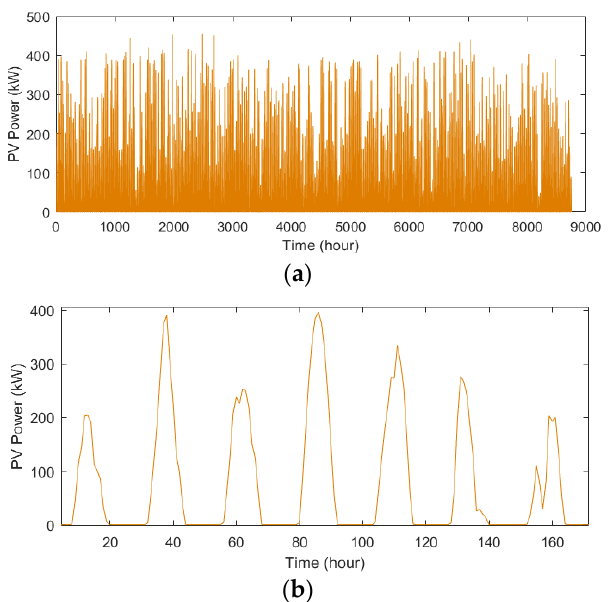
Figure 13. Generated power by PV resources in the sizing of the HPV/FC energy system via the IAEO, considering ENSP max = 5% during ( a ) a year and ( b ) a week.